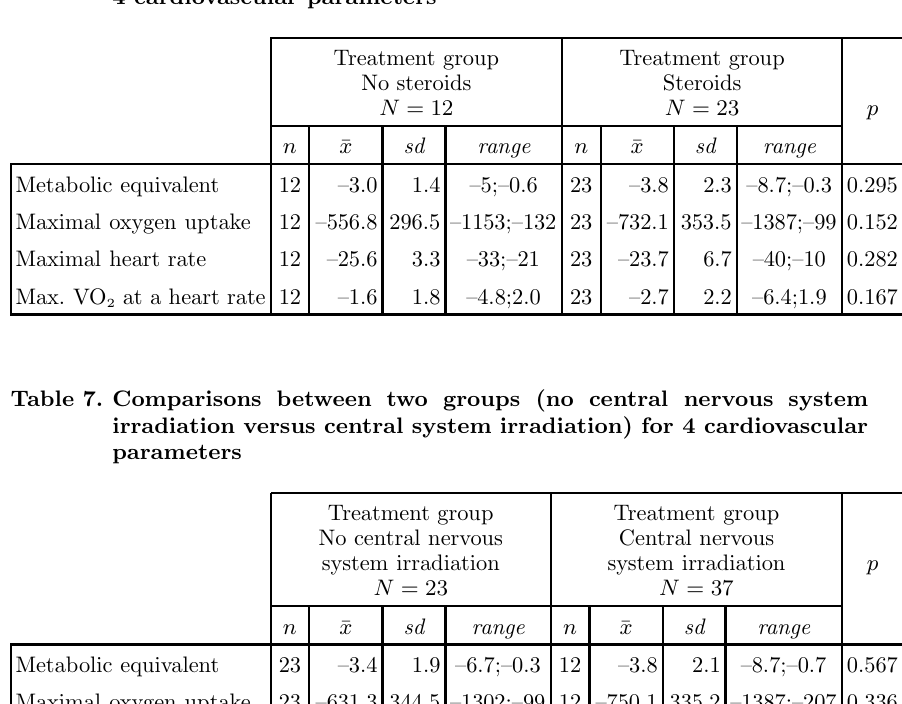
Table 6. Comparisons between two groups (no steroids versus steroids) for 4 cardiovascular parameters